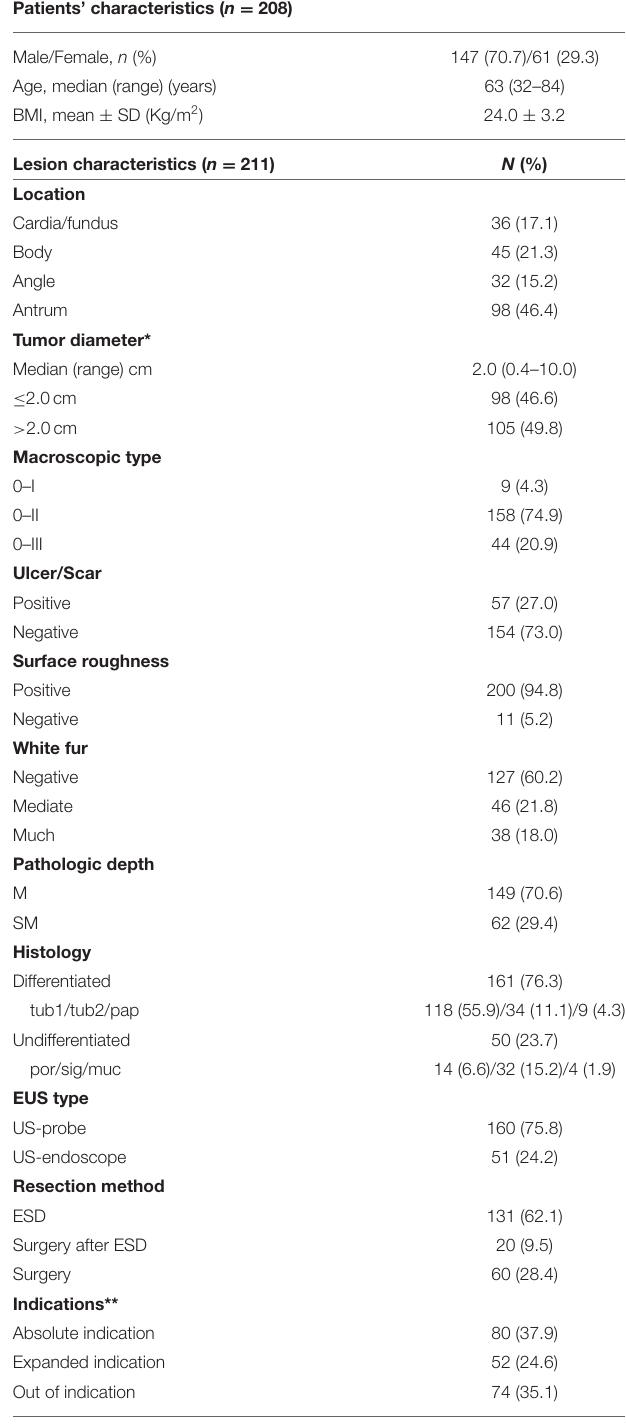
TABLE 1 | The clinicopathological characteristics of subjects. Patients’ characteristics ( n =